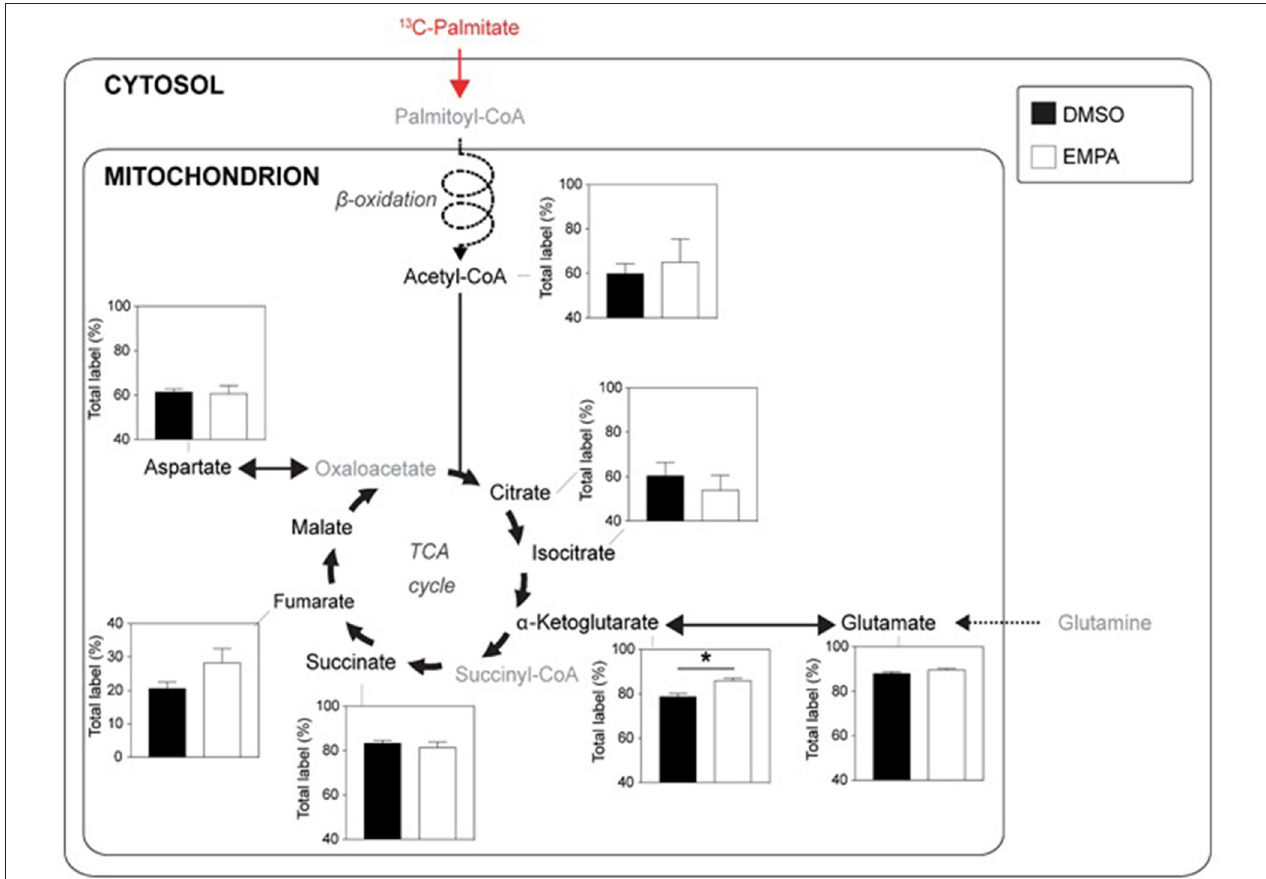
FIGURE 3 | EMPA’s direct effects on palmitate metabolism of db/db hearts. 13 C-labeling in metabolites of the TCA cycle when hearts were perfused with 0.4mM 13 C palmitate; DMSO ( n = 5), EMPA ( n = 8), % = % metabolite labeled with 13 C; * P < 0.05.